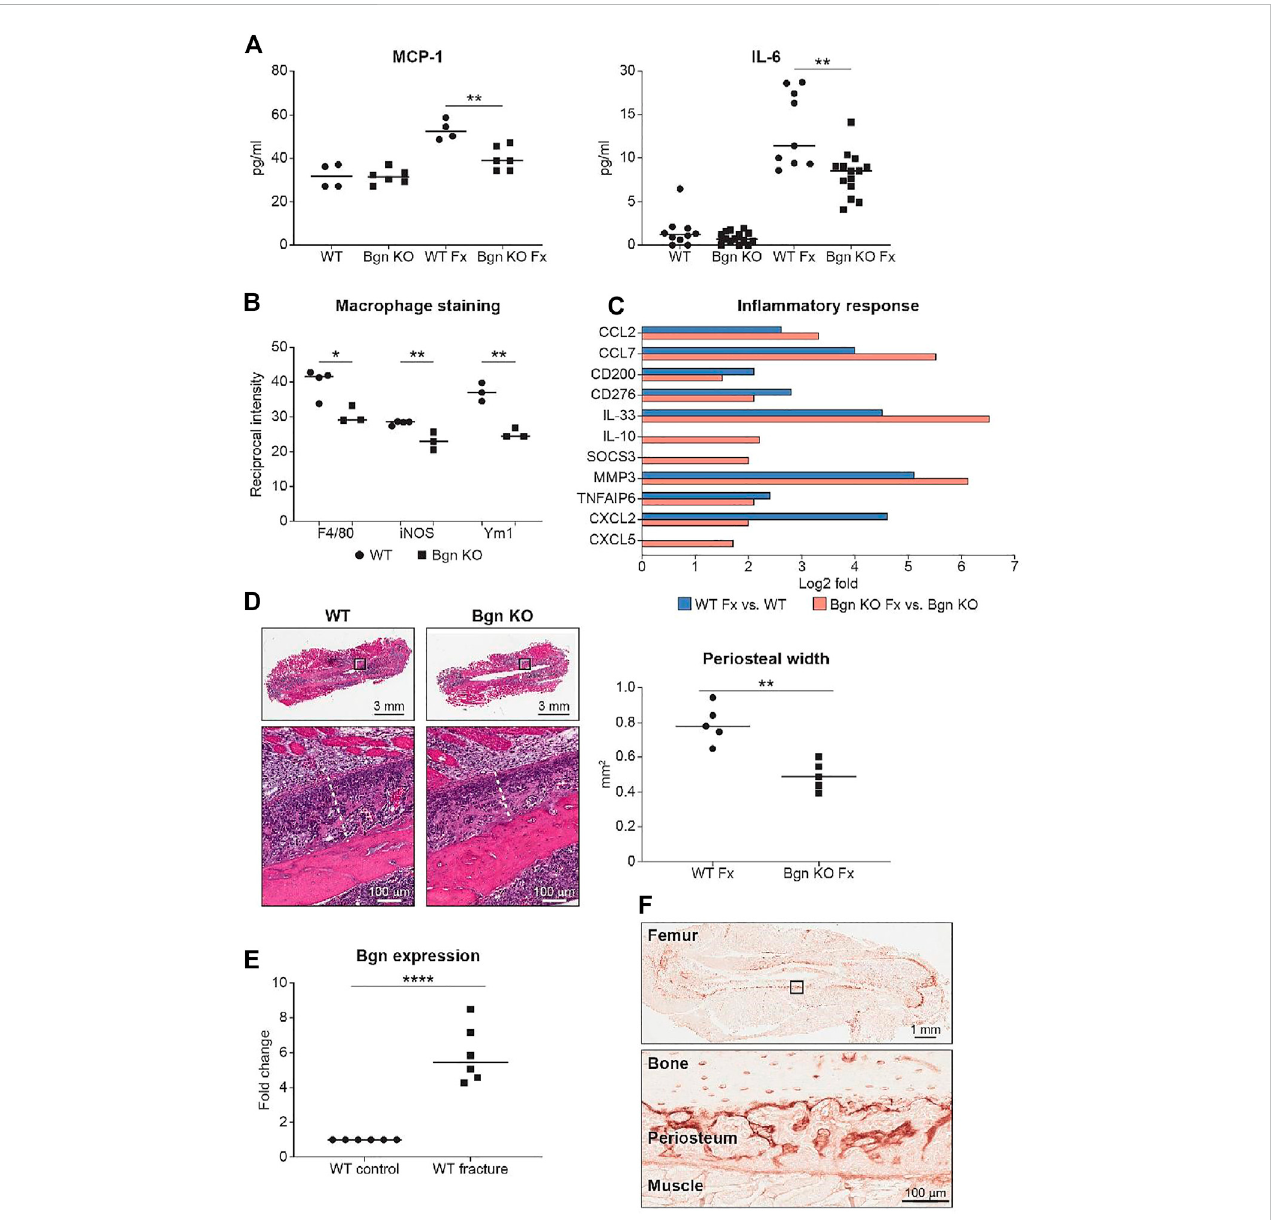
FIGURE 3 Bgnis neededfor thein fl ammatory responseafter fracture. (A) Analysisofsystemic cytokine secretion 24 hafter fracture (Fx — Fracture).(ForMCP-1, n = 4/6 per group; for IL-6, n = 10/14 per group) (B) Quanti fi cation of immunostaining for F4/80, iNOS and Ym1 around the fracture site 72 h after fracture ( n = 3pergroup).SeealsoSupplementaryFigureS3. (C) GOanalysisofRNAseqdataforgenesinvolvedinthein fl ammatoryresponsebeforeand72 hafterfracture ( n =6per group). (D) Representative imagesand quanti fi cationofperiostealwidth72 hafter fracture ( n =5per group). (E) Real-timePCR analysis of Bgn gene expression in WT bones before and 3 days after fracture ( n = 6 per group). (F) Immunohistochemistry of Bgn in the periosteum 72 h after fracture, representative images ( n = 5 per